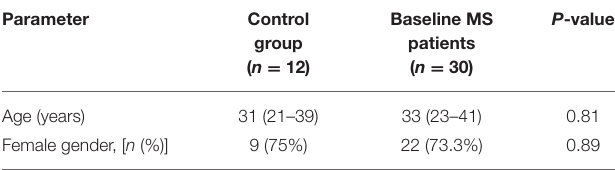
TABLE 2 | Age and gender in both control group and MS